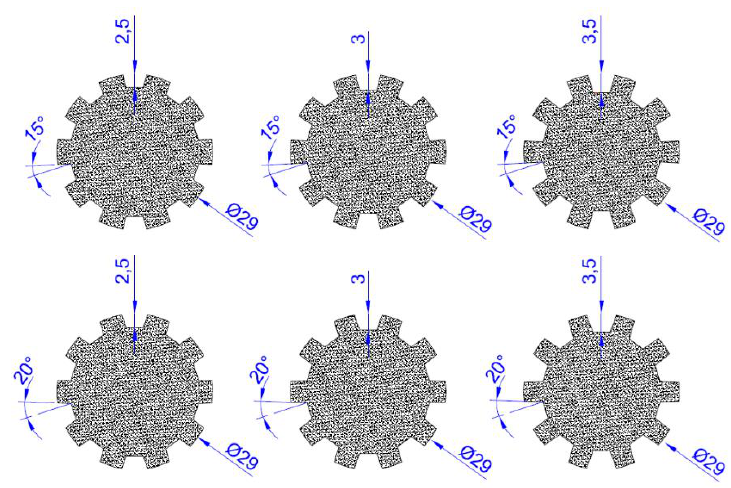
Figure 1. Geometric variation of experimented spline shafts, dimensions are in [mm], and angle is in degrees [°].